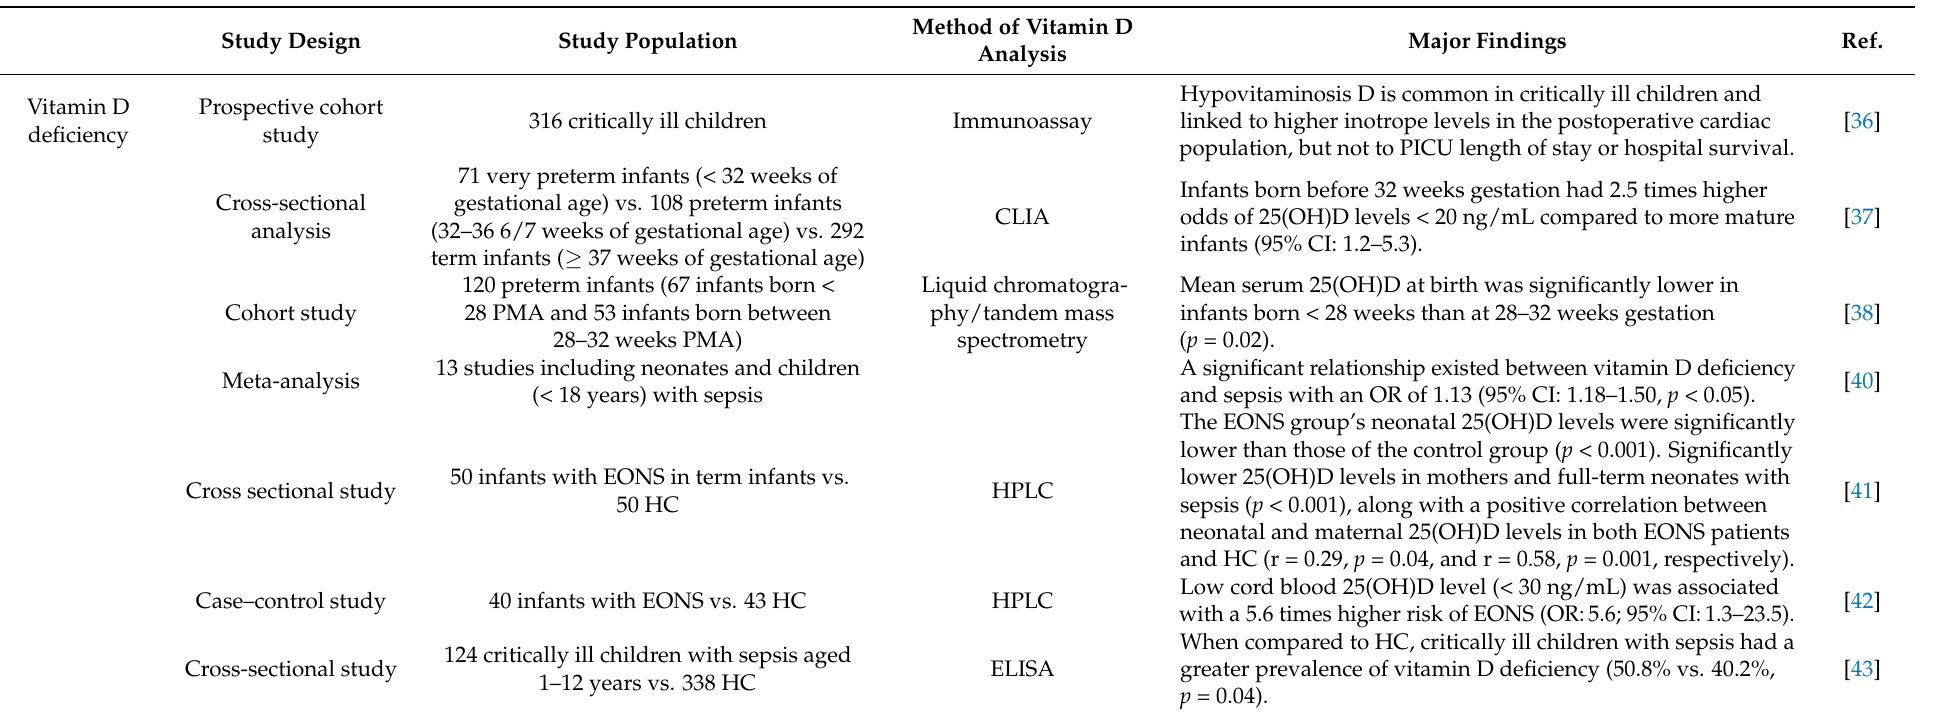
Table 1. Overview of studies investigating vitamin D deficiency and vitamin D supplementation in neonates and children with